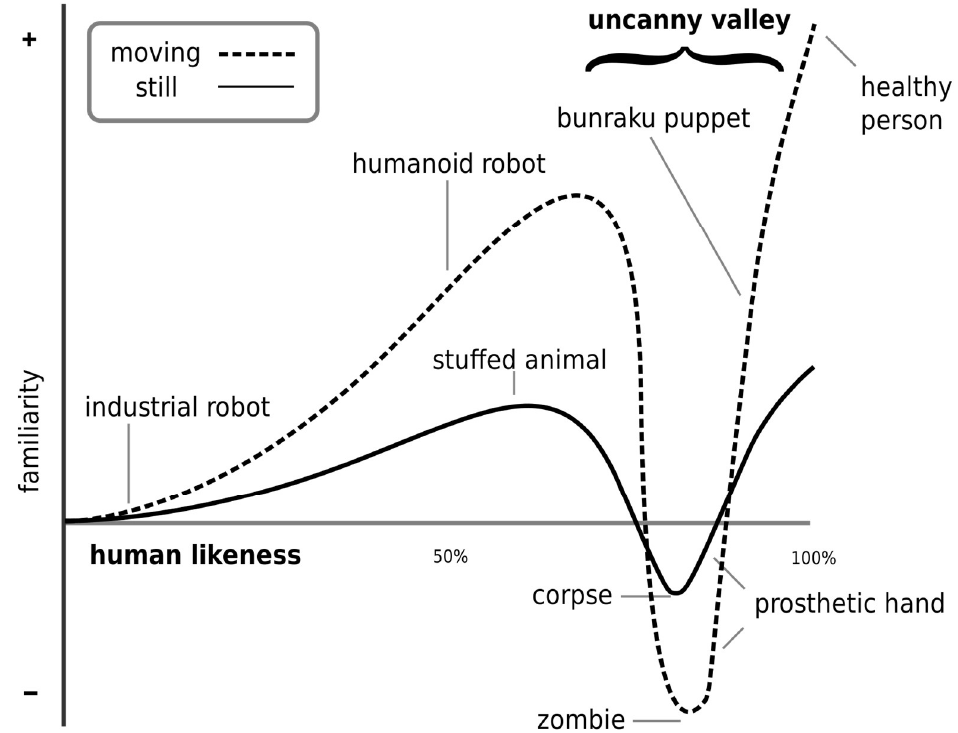
Figure 1. Mori’s uncanny valley for some representative moving and still systems [2]. Of particular interest is the prosthetic hand, which displays high human likeness yet low familiarity or comfort level with an observer or someone interacting with the device.